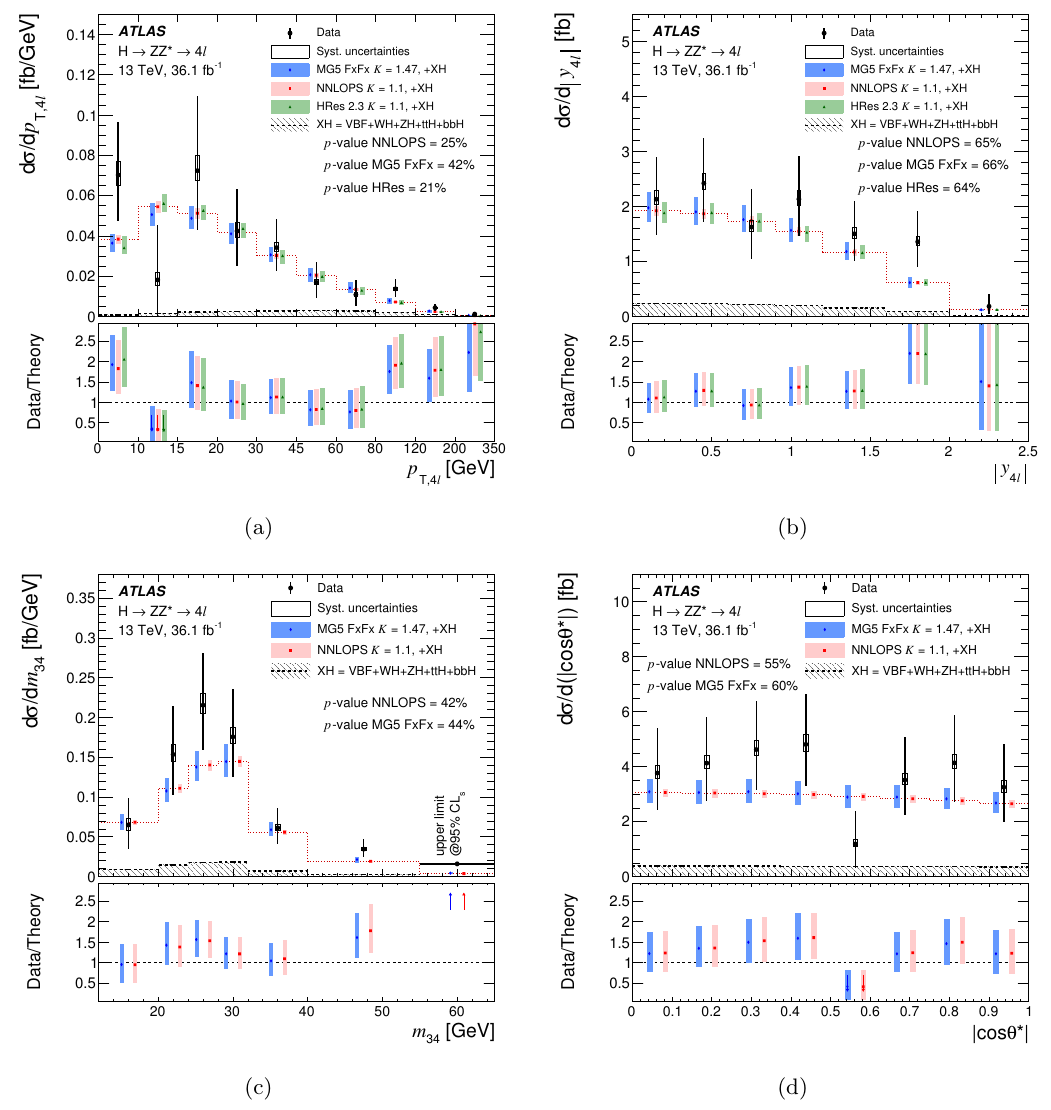
Figure 8. Di(cid:11)erential (cid:12)ducial cross sections, for (a) the transverse momentum p T ; 4 ‘ of the Higgs boson, (b) the absolute value of the rapidity j y 4 ‘ j of the Higgs boson, (c) the invariant mass of the subleading lepton pair m 34 , (d) the magnitude of the cosine of the decay angle of the leading lepton pair in the four-lepton rest frame with respect to the beam axis j cos (cid:18) (cid:3) j . The measured cross sections are compared to ggF predictions by NNLOPS , MG5 aMC@NLO FxFx , and, for p T ; 4 ‘ and j y 4 ‘ j , by HRes , all normalized to the N3LO cross section with the listed K -factors. Predictions for all other Higgs boson production modes XH are added. The error bars on the data points show the total uncertainties, while the systematic uncertainties are indicated by the boxes. The shaded bands on the expected cross sections indicate the PDF and scale uncertainties. The p -values indicating the compatibility of the measurement and the SM prediction are shown as well. They do not include the systematic uncertainty in the theoretical predictions.